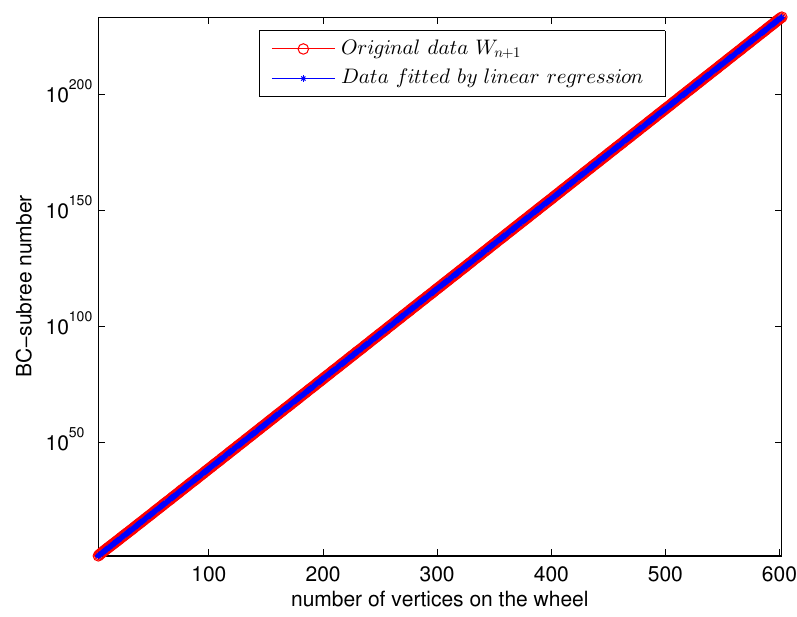
Figure 4. Original BC-subtree number and the corresponding data fitted by linear regression of W n + 1 ( n = 3,4, . . . ,602 )